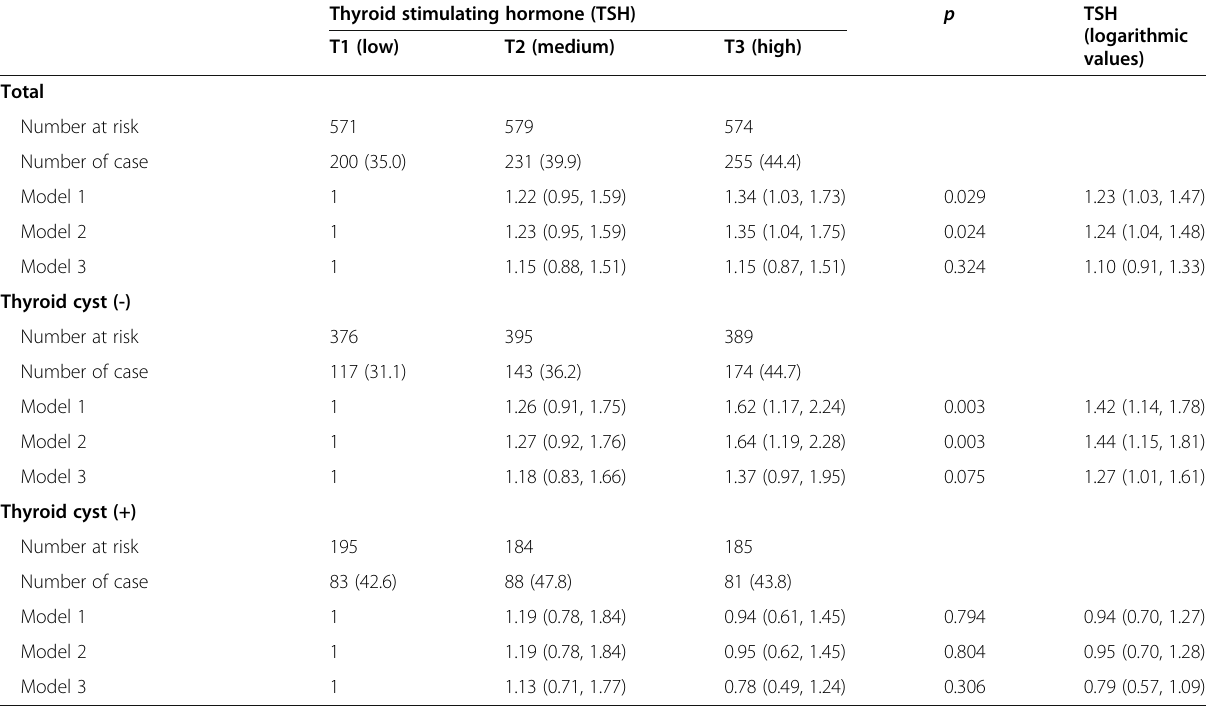
Table 3 Odds ratios (ORs) and 95% confidence intervals (CIs) for hypertension in relation to thyroid stimulating hormone (TSH) Thyroid stimulating hormone